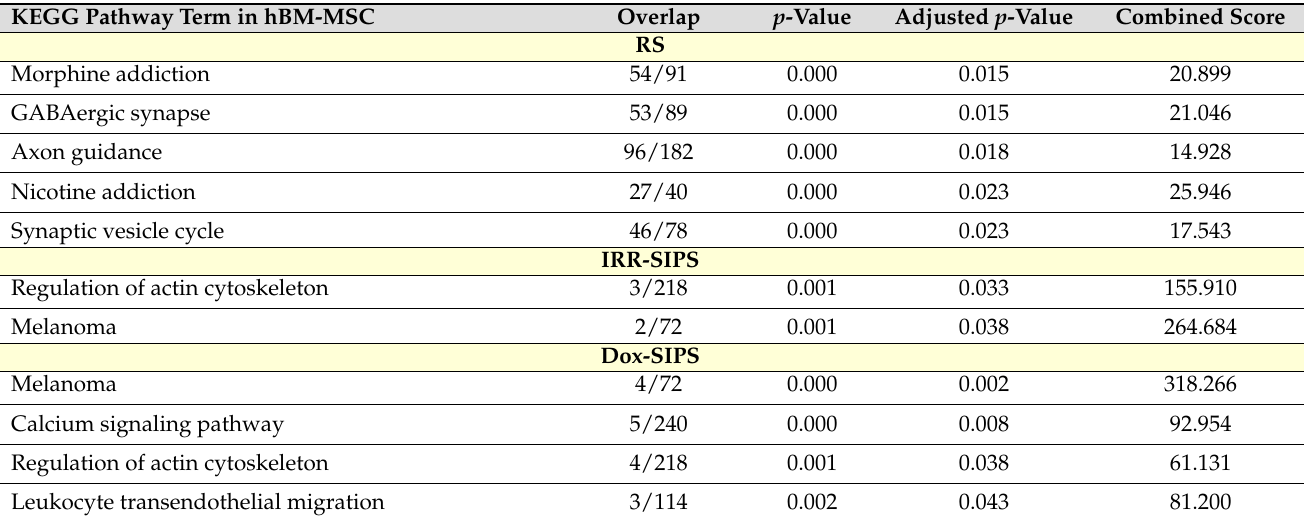
Table 5. Results of pathway enrichment analysis for hBM-MSC after replicative, irradiation- and doxorubicin-induced senescence (respectively RS, IRR-SIPS and Dox-SIPS). Only the terms for which adjusted p -value reached the statistical significance level of 0.05 are listed. For the description of column names, please refer to Table